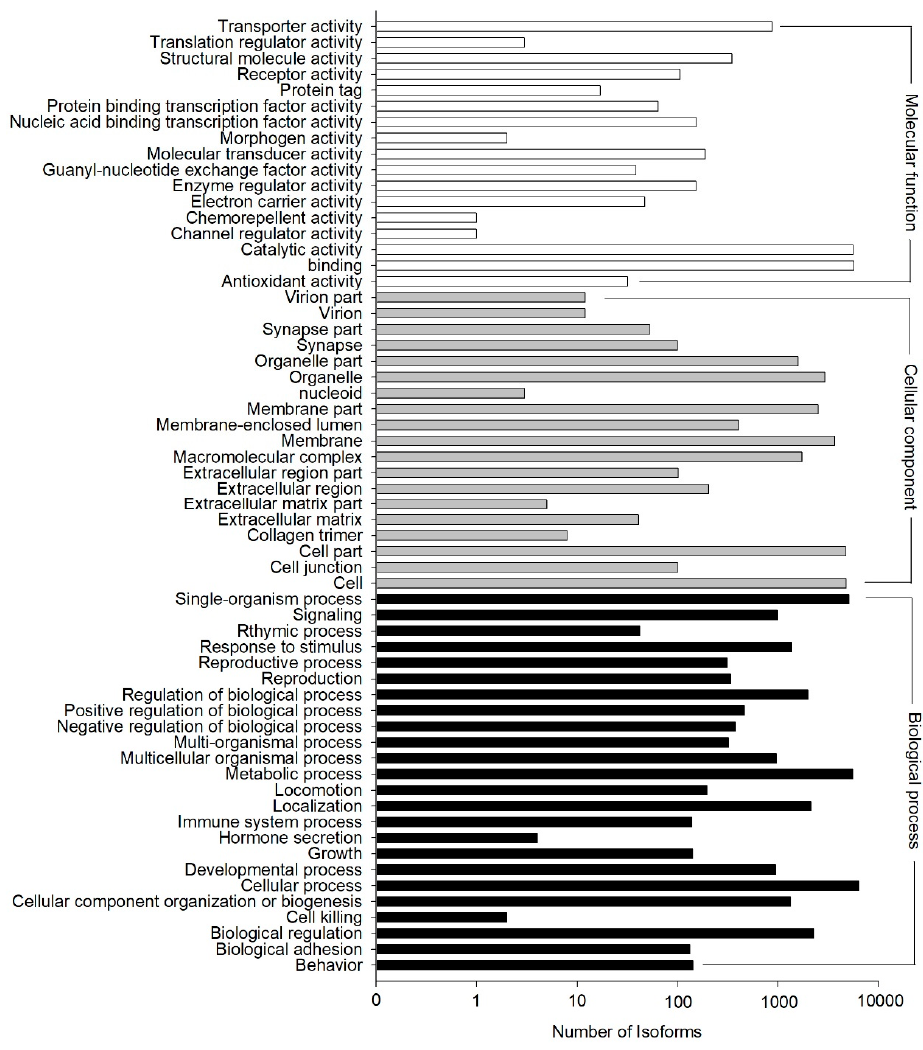
Figure 4. Functional distribution of Gene Ontology (GO) annotation. X-axis represents the number of isoforms. Y-axis represents the Gene Ontology function category.